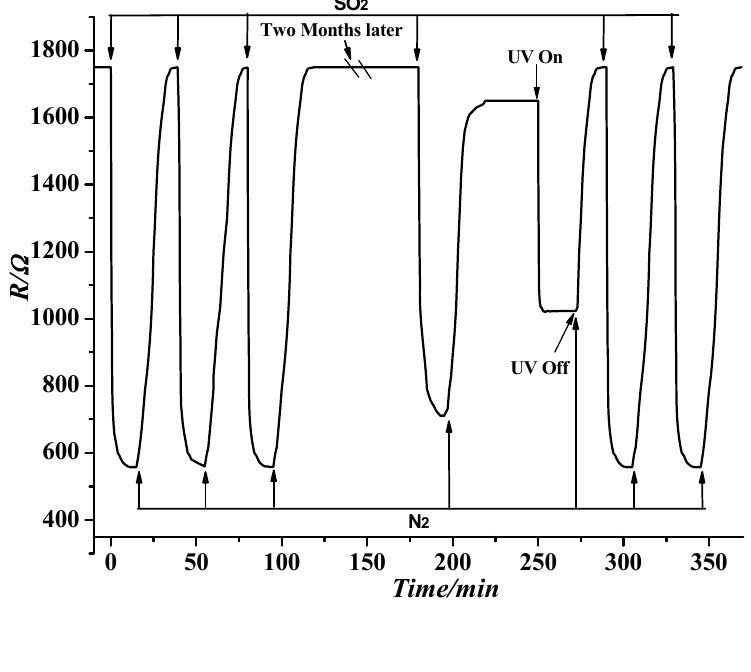
Figure 10. TiO nanotube array sensor stability testing 2